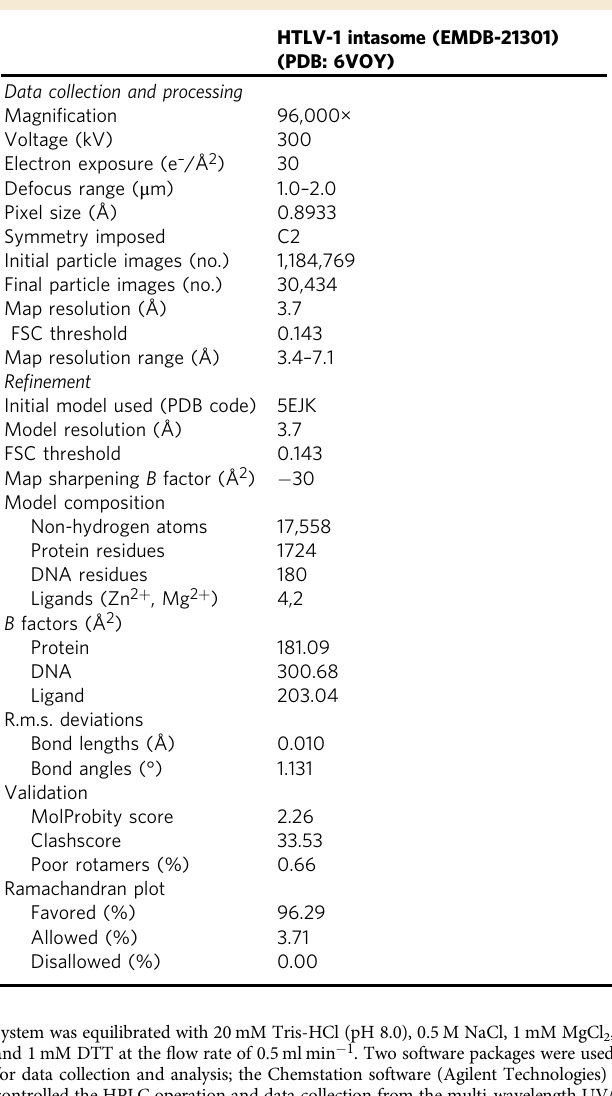
Table 1 Cryo-EM data collection, re fi nement, and validation